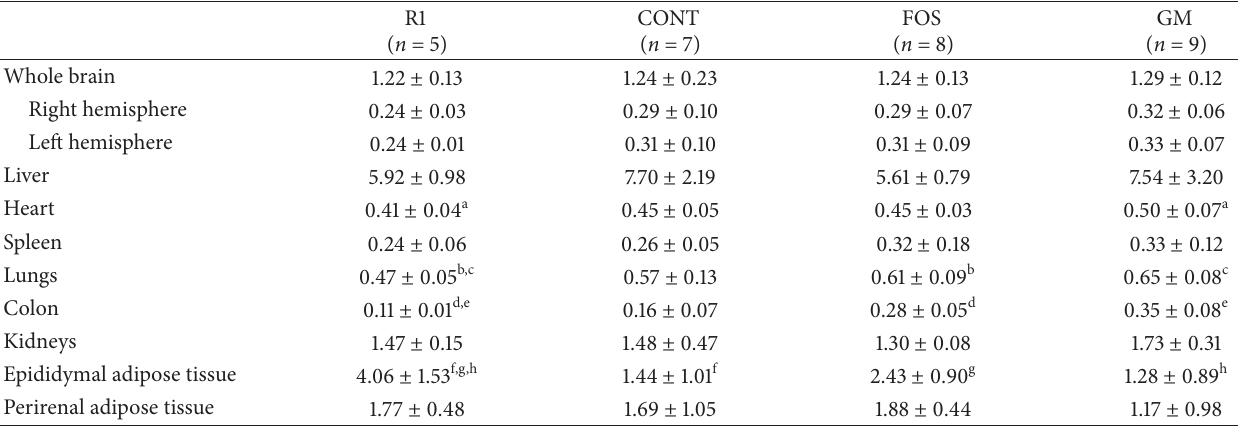
Table 2: Relative weight of whole brain, right hemisphere, left hemisphere, colon, organs, and adipose tissues in SAMP8 at 38 weeks after